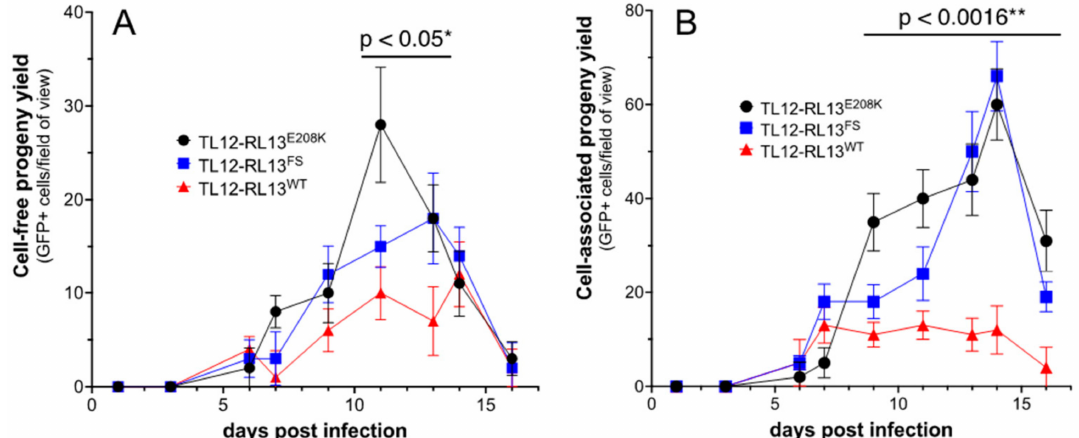
Figure 6. The E208K substitution relieves RL13 restriction of viral replication. Replicate MRC-5 cultures were infected with the indicated viruses at an MOI of 0.3 pfu/cell. On alternate days, post-infection progeny virus yields were determined in culture supernatants (cell-free progeny, A ) or in cell sonicates (cell-associated, B ) by infecting fresh monolayer cultures and counting the numbers of GFP+ cells per field of view at day three post-infection. Data shown are means of triplicate assays +/ − one standard deviation. * TL12-RL13 E208K vs. TL12-RL13 WT , days 11–13; ** TL12-RL13 E208K vs.